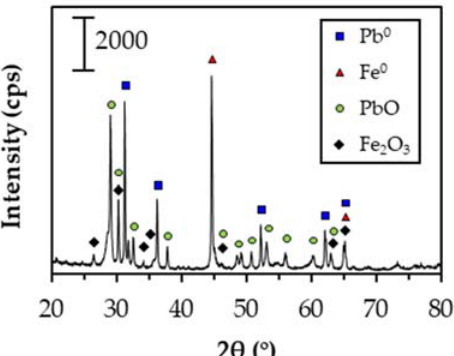
Figure 7. XRD pattern of the residue of the cementation experiment using 1 g/10 mL of ZVI for 24